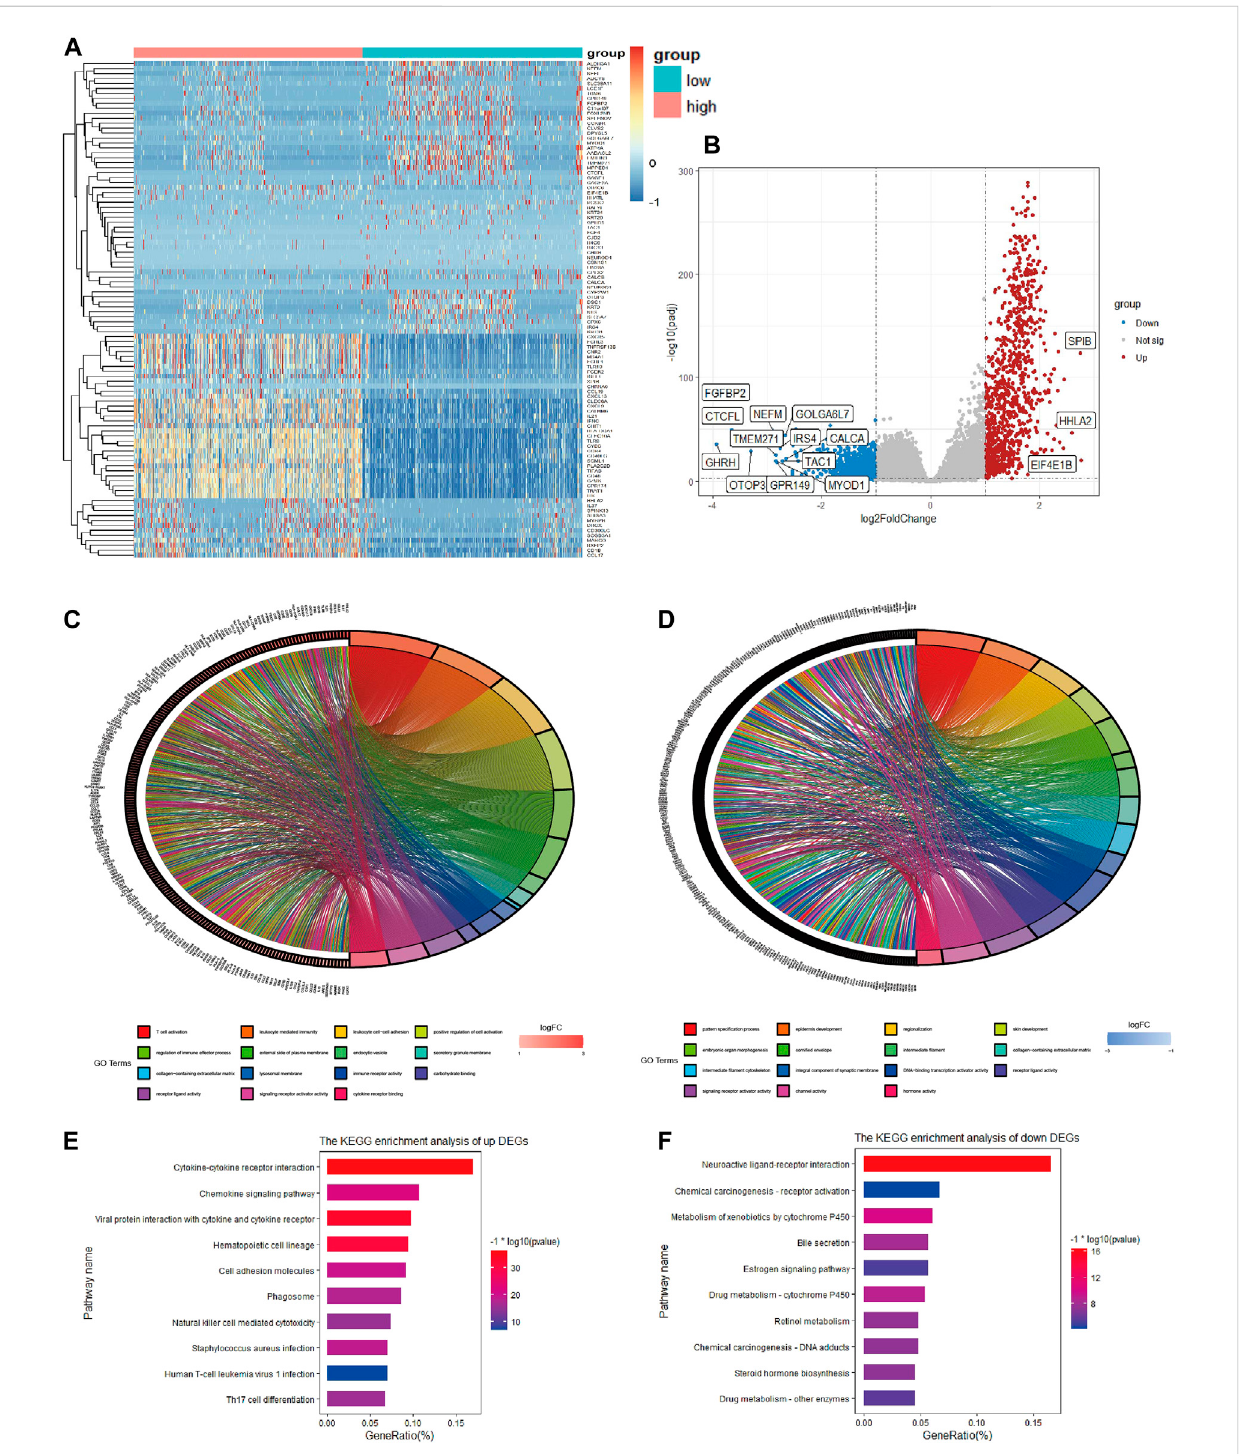
FIGURE 3 Heatmap,volcanoplotandenrichmentanalysisofGOandKEGGforDEGs (A) .HeatmapofDEGsinTCGA (B) .VolcanoplotofDEGsinTCGA (C) .Top 5 enriched biological processes, molecular functions, and cellular components of upregulated co-DEGs and (D) downregulated co-DEGs (E) . Top 10 KEGG pathways of upregulated co-DEGs and (F) downregulated